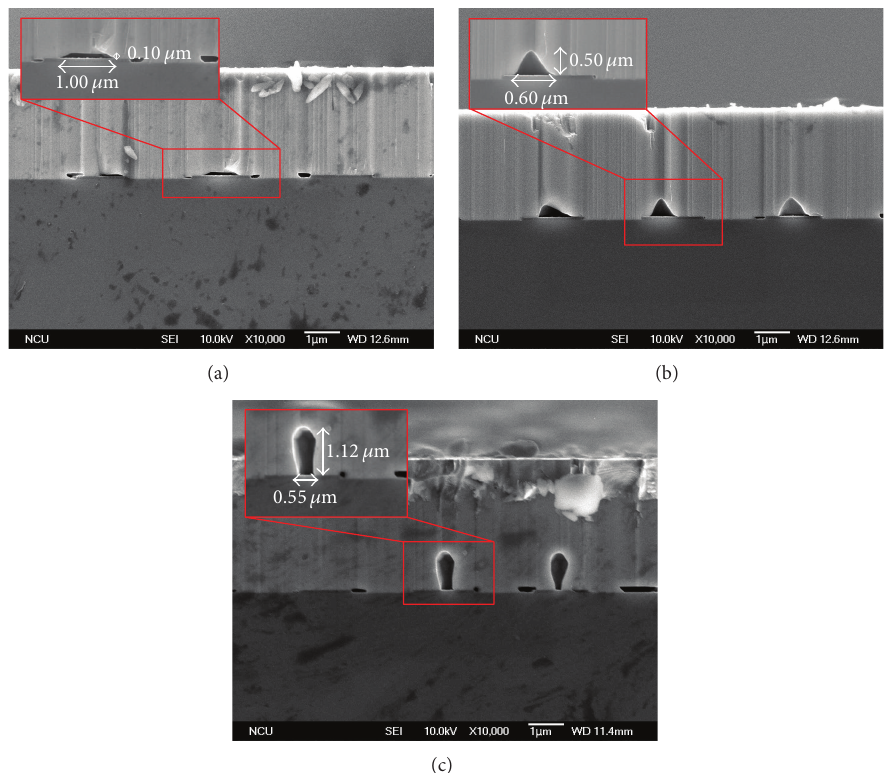
Figure 2: Cross-sectional SEM images of (a) sample-R, (b) sample-T, and (c) sample-P.